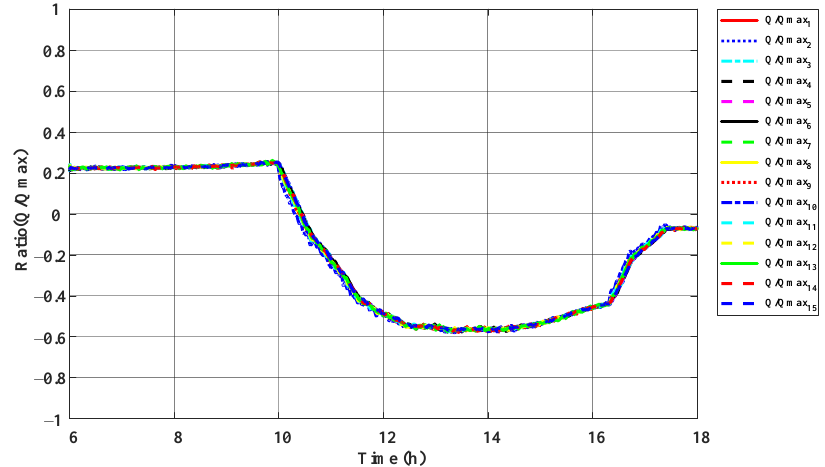
Figure 12. The q / c ratio of the PV with voltage control.